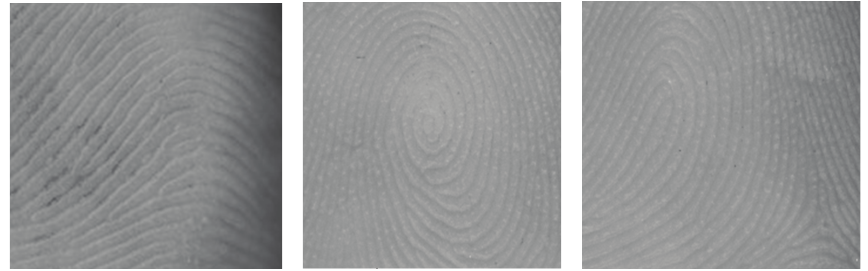
Figure 1: Examples of finger ridge patterns: 1 = arch; 2 = whorl; 3 =